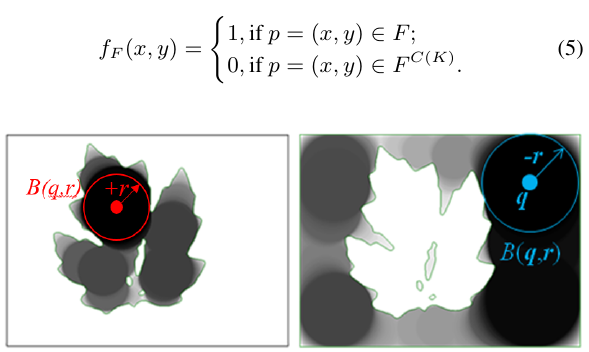
Figure 2: Left: thickness map for foreground; Right: thickness map for background.